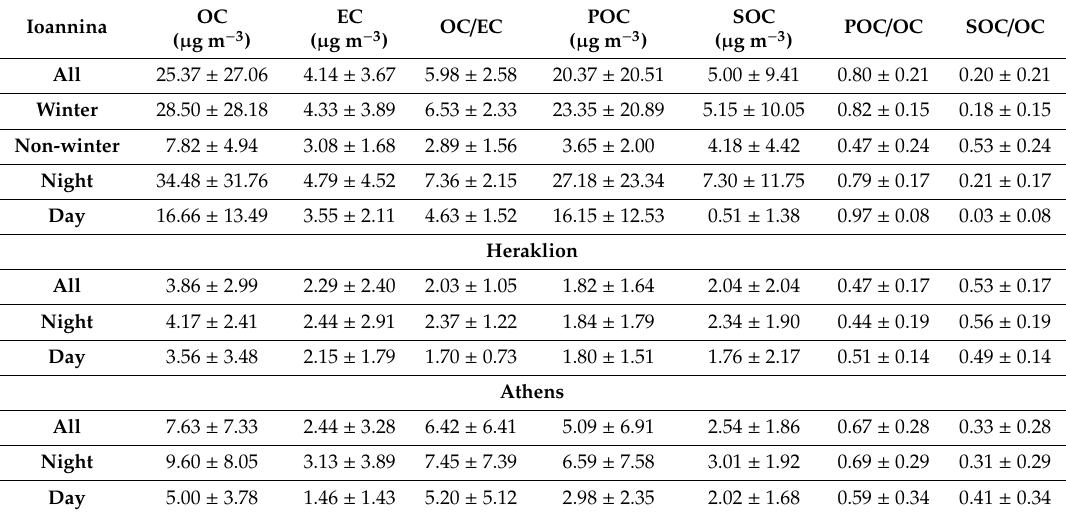
Table 1. Mean values of carbonaceous-aerosol parameters at the study sites. POC (primary organic carbon) and SOC (secondary organic carbon) refer to estimates by the minimum R -squared (MRS) method. OC: organic carbon; EC: elemental